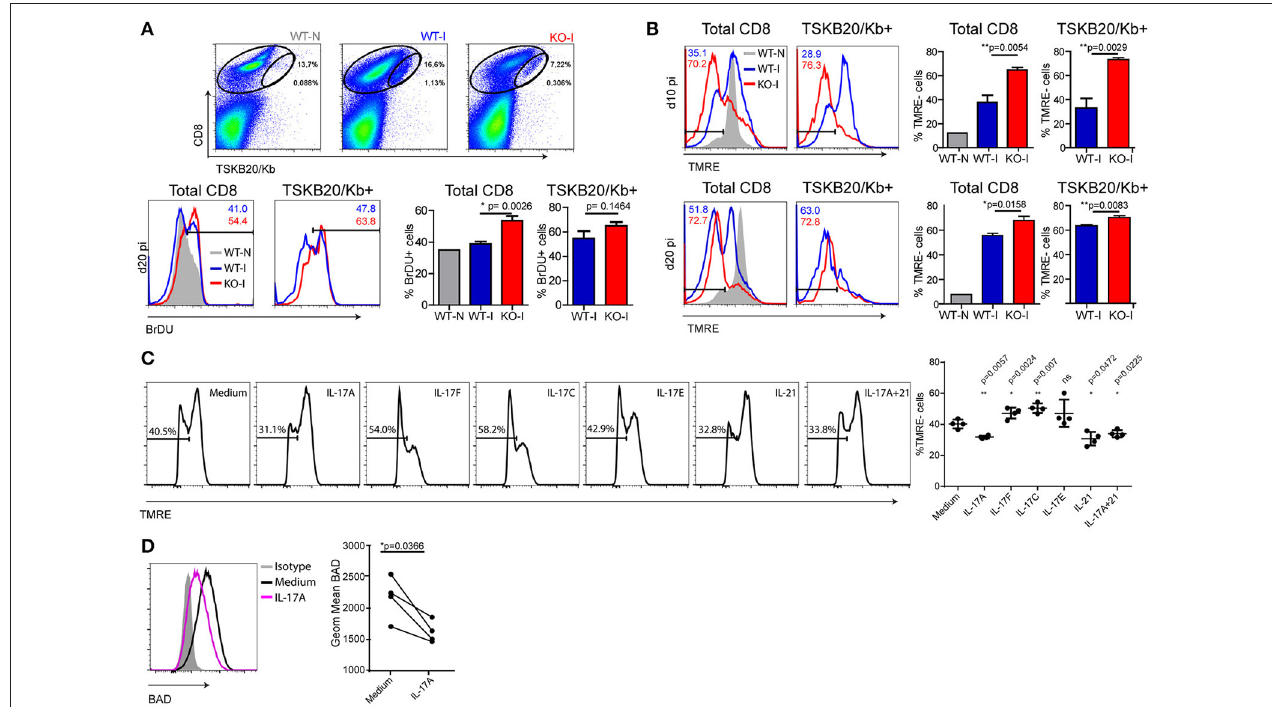
FIGURE 2 | IL-17RA signaling during T. cruzi infection promotes survival of CD8 + T cells. (A) Representative dot plots of CD8 and TSKB20/Kb staining and representative histograms of BrDU in cell suspensions from the spleen of WT and KO mice at 0 dpi (WT-N) and 20 dpi (WT-I and KO-I) and within the indicated total and TSKB20/Kb + CD8 + T cell gates. Numbers in the histograms indicate the frequency of BrDU + cells from the corresponding colored group. Histograms are representative of one out of five mice. Bars in the statistical analysis represent data as mean ± SD, N = 5 mice. P values were calculated with two-tailed T test. (B) Representative histograms of TMRE staining in total (left) and TSKB20/Kb + (right) CD8 + T cells from the spleen of WT and IL17RA KO mice at 10 dpi (top) and 20 dpi (bottom). Numbers indicate the frequency of TMRE- (apoptotic) cells in total and TSKB20/Kb + CD8 + T cells from the corresponding colored group. Gray tinted histogram show staining in CD8 + T cells from non-infected WT mice (WT-N). Histograms are representative of one out of five mice. Bars in the statistical analysis represent data as mean ± SD, N = 5 mice. P values were calculated with two-tailed T test. (C, D) Representative histograms of TMRE (C) and BAD (D) stainings in cultures of purified CD8 + T cells activated with coated anti-CD3 and anti-CD28 in the presence of the indicated cytokines. Statistical analysis in (C) shows the frequency of TMRE- (apoptotic) cells in each biological replicate ( N = 4 mice) and the mean ± SD . P values calculated with paired two-tailed T test (ns, not significant). Statistical analysis in (D) represent protein expression as the geometric mean of fluorescence intensity in each replicate ( N = 4 mice). Lines link paired samples. P values calculated with paired two-tailed T test. Data in (A-D) are representative of three and two independent experiments,